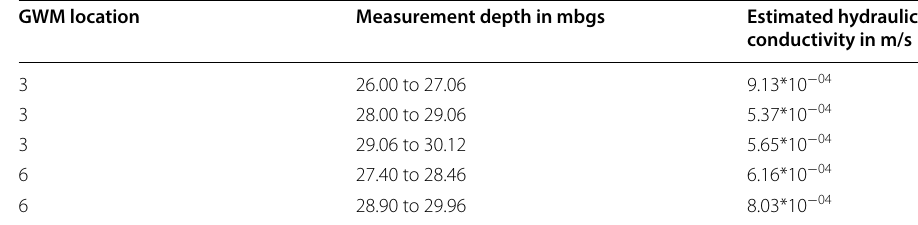
Table 1 Estimated hydraulic conductivities at GWM locations 3 and